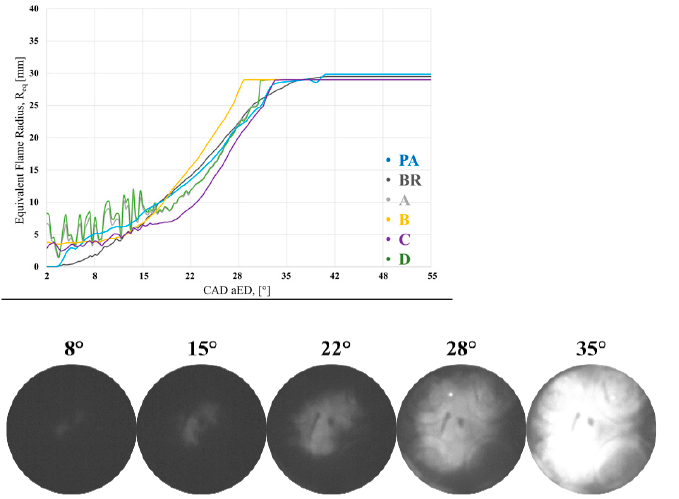
Figure A2. Equivalent radii for the cases studied in Table 2. Five images are showed in order to visual estimate the corresponding flame front propagation.